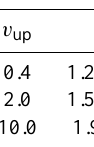
from Table 1 for three values N s